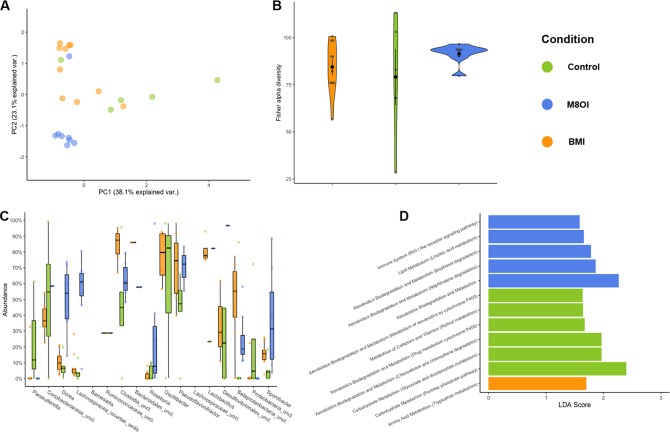
Impact of ionic liquid exposure on gut microbiota composition.A, Panels illustrate beta diversity, expressed as Bray-Curtis dissimilarity. B, alpha diversity, expressed as fisher-alpha diversity. C, significantly differential abundant microbial genera identified. D, KEGG functional pathways identified between exposure groups. Each point in panels a–c represents an individual sample. Points are coloured by exposure condition (M8OI = blue; BMI = orange; Control = green). Ordination in panel A describes 61% of the total dissimilarity between samples. KEGG pathways in panel D were identified by PiCrust metagenome predictions based on taxonomic composition.